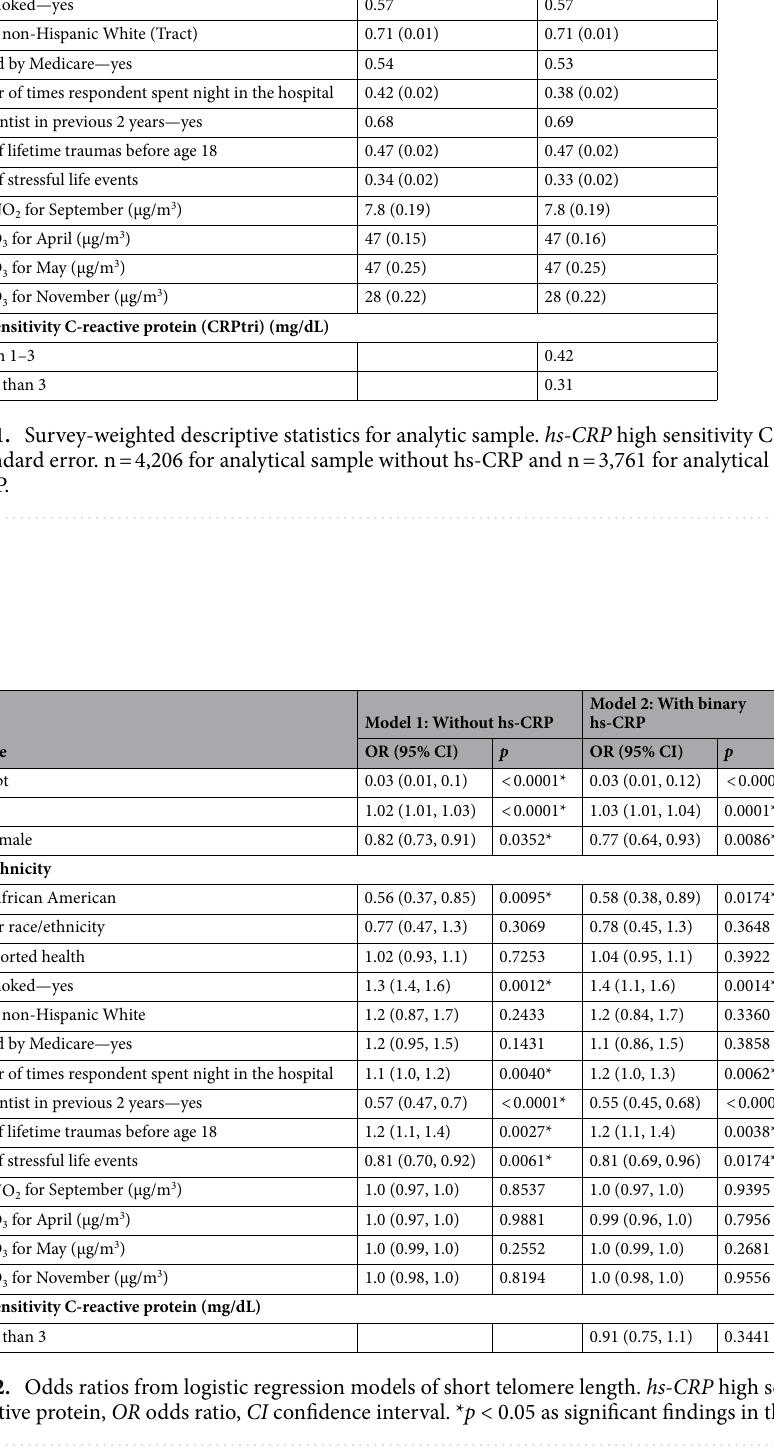
Table 2. Odds ratios from logistic regression models of short telomere length. hs-CRP high sensitivity C-reactive protein, OR odds ratio, CI confidence interval. * p < 0.05 as significant findings in this analysis.